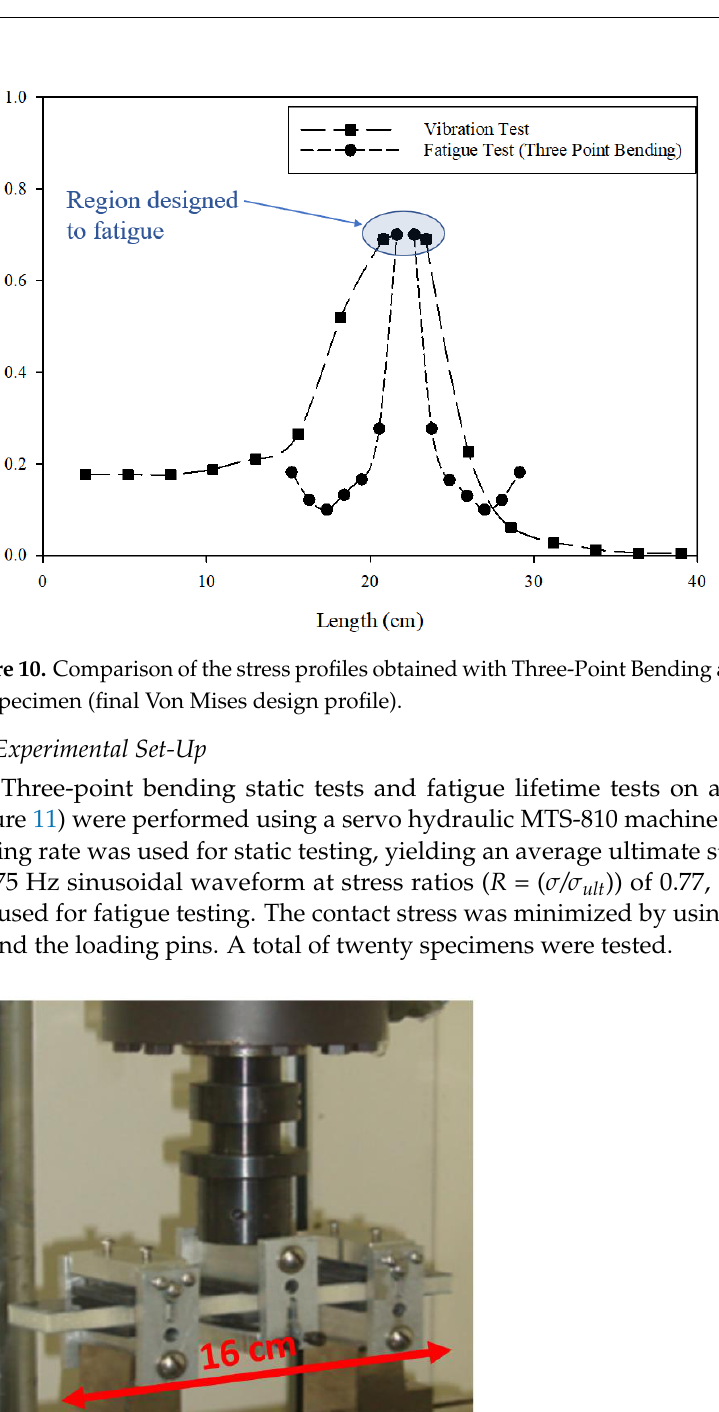
Figure 9. Stress profile after modifying L3 and L2.